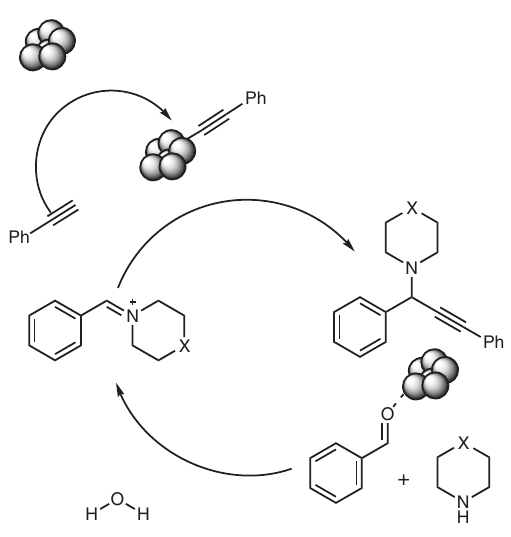
Scheme 3: Proposed mechanism for the synthesis of